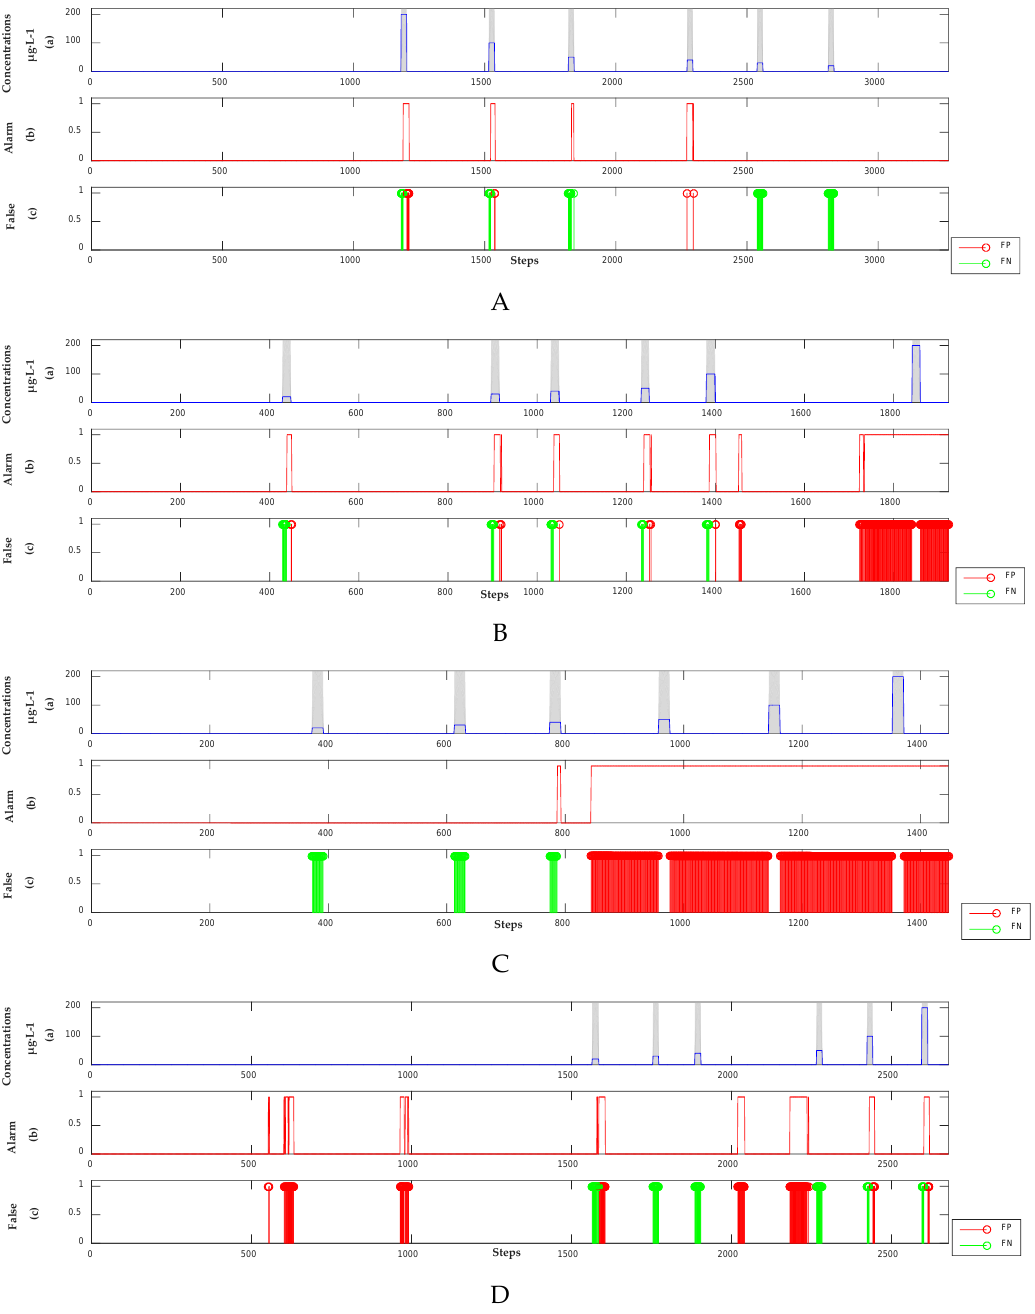
Figure 9. Detection results of the unsupervised model. (Panel ( A )) The concentrations, alarm signals and FP points and FN points of phenol; (Panel ( B )) The concentrations, alarm signals and FP points and FN points of m-phenylenediamine; (Panel ( C )) The concentrations, alarm signals and FP points and FN points of hydroquinone; (Panel ( D )) The concentrations, alarm signals and FP points and FN points of resorcinol.